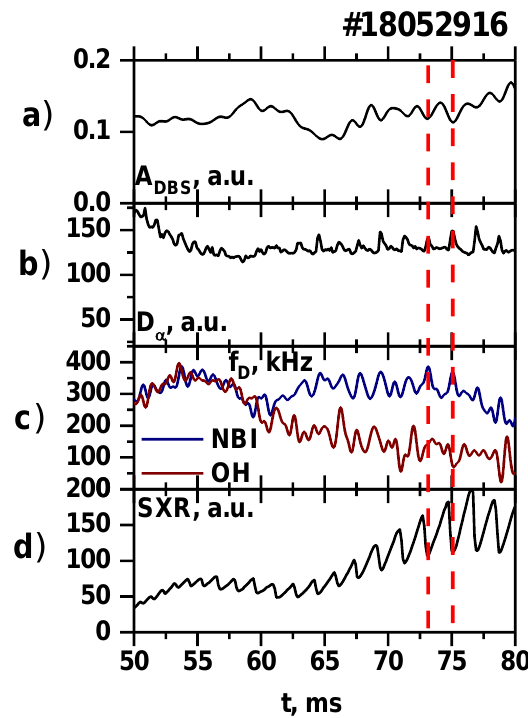
Figure 9. Plasma parameters characterizing MHD activity: ( a ) electron density n e , ( b ) magnetic probe signal, ( c ) Doppler frequency shift f D .